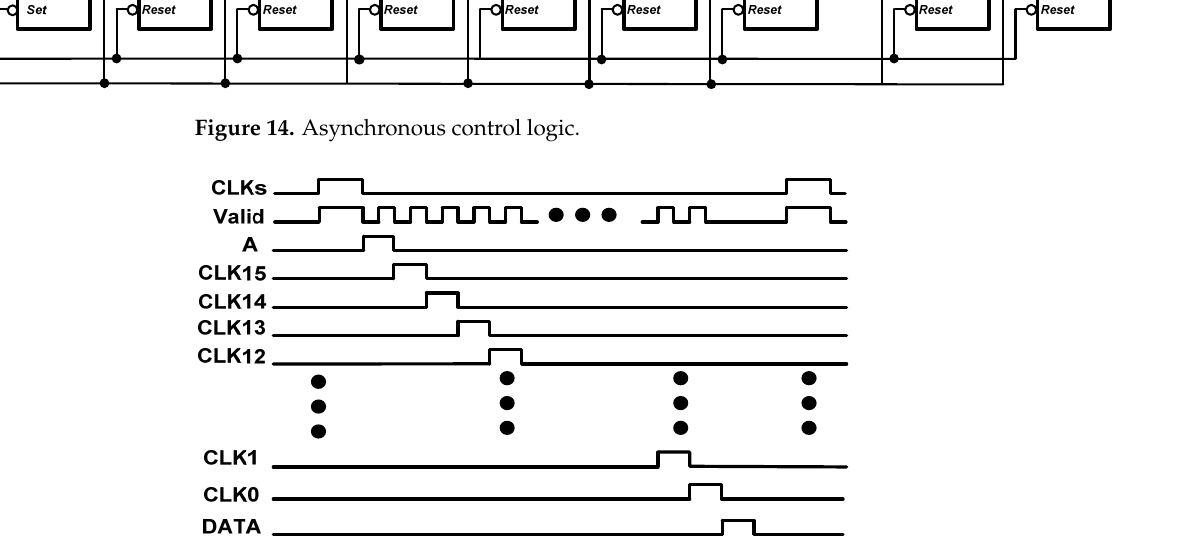
Figure 15. Timing of the asynchronous control logic.